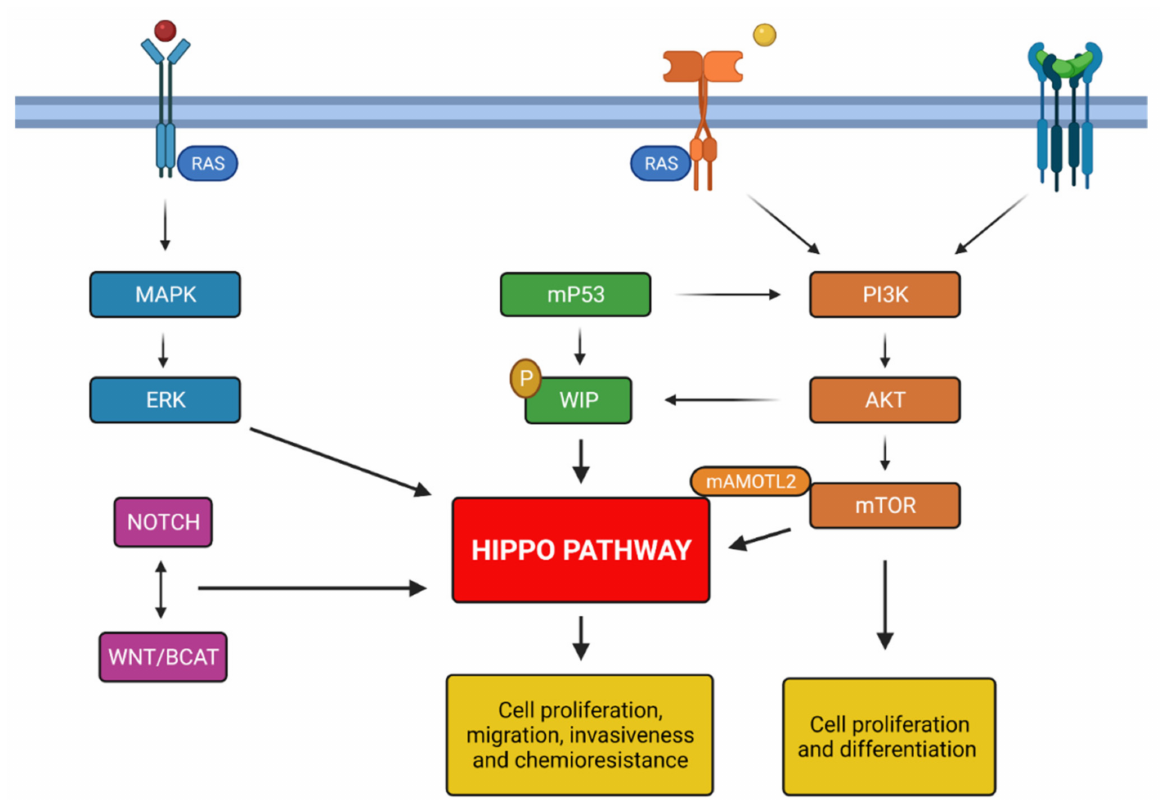
Figure 2. Summary of principals molecular mechanisms involved in glioblastoma genesis; all pathways described activate Hippo pathway promoting the chemoresistance and tumorigenesis. Created with